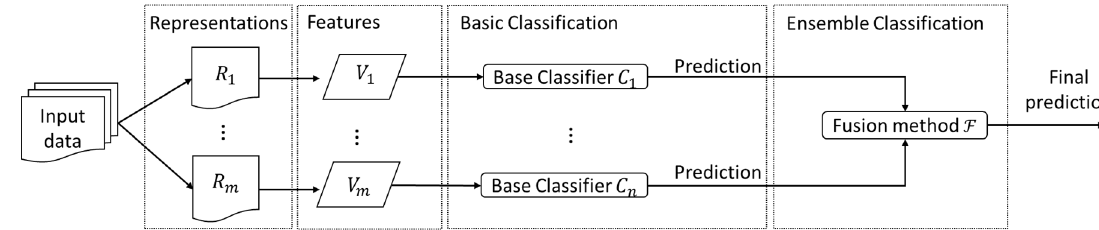
Figure 1. General structure of a classification model using different features V of representations R of input data for an ensemble of n base classifiers C merged by a fusion method F .